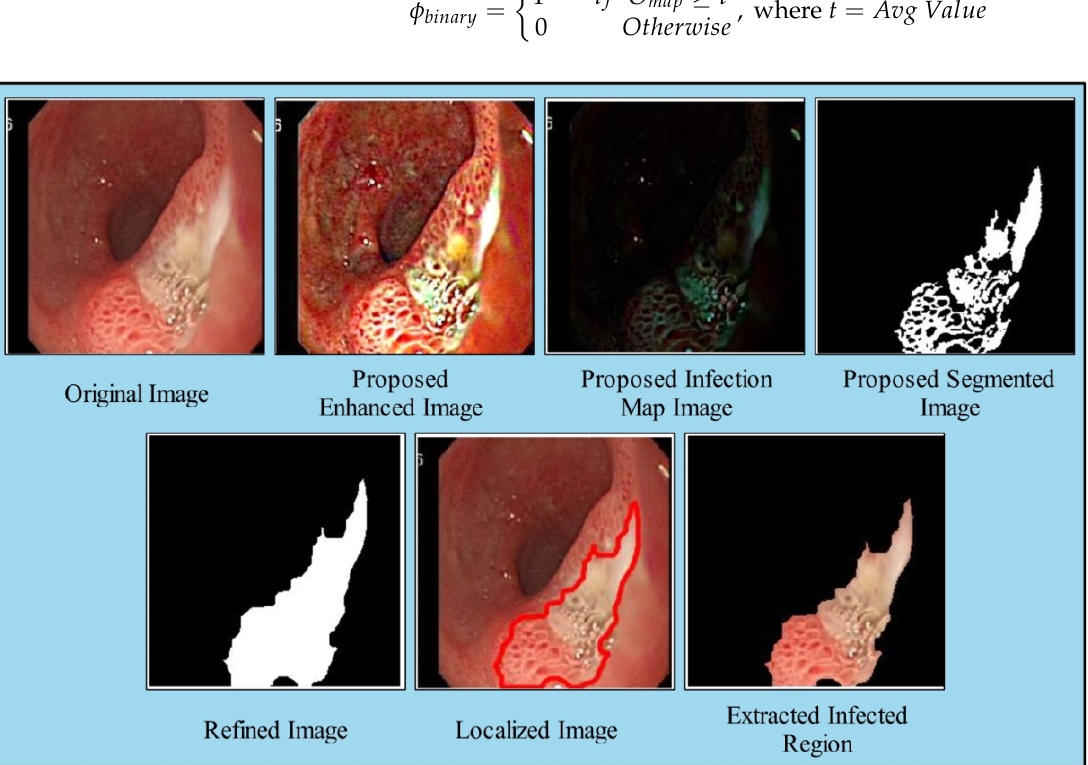
Figure 4. Proposed saliency based infected region detection.